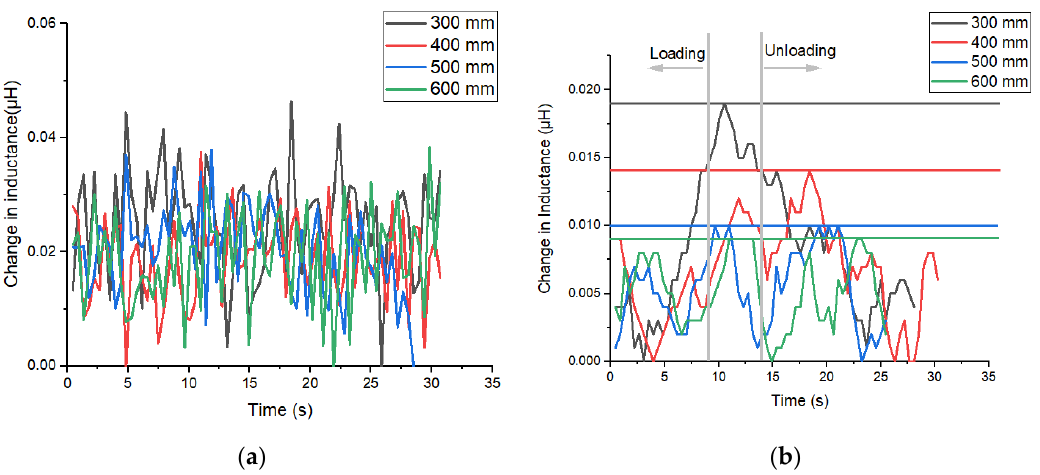
Figure 12. ( a ) Change in inductance with off-the-shelf 0.6 μH Farnall inductor ( b ) Change in inductance by adding shielded inductor in series to the Farnall 0.6 μH inductor where the lines are a guide to the